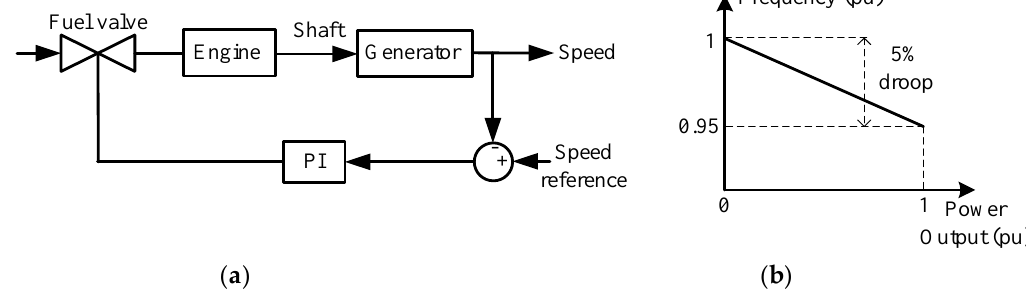
Figure 7. ( a ) Frequency droop control; ( b ) Frequency droop characteristic.